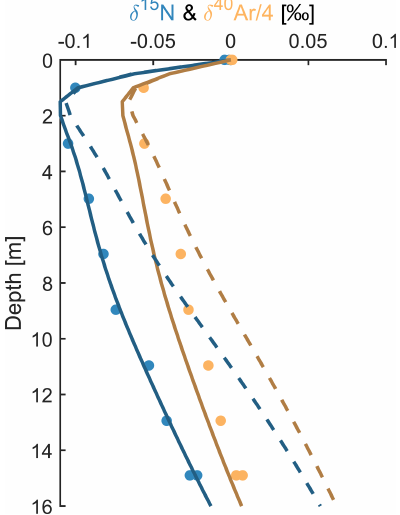
Figure 7. Shallow firn air data from the winter sampling campaign at the South Pole by Severinghaus et al. (2001). Solid lines are a firn air model run that includes a slow downward advection of air between 0 and 25m (see text for details). Dashed lines are the model run without any downward advection, as shown in Fig. 5 in Sever- inghaus et al.